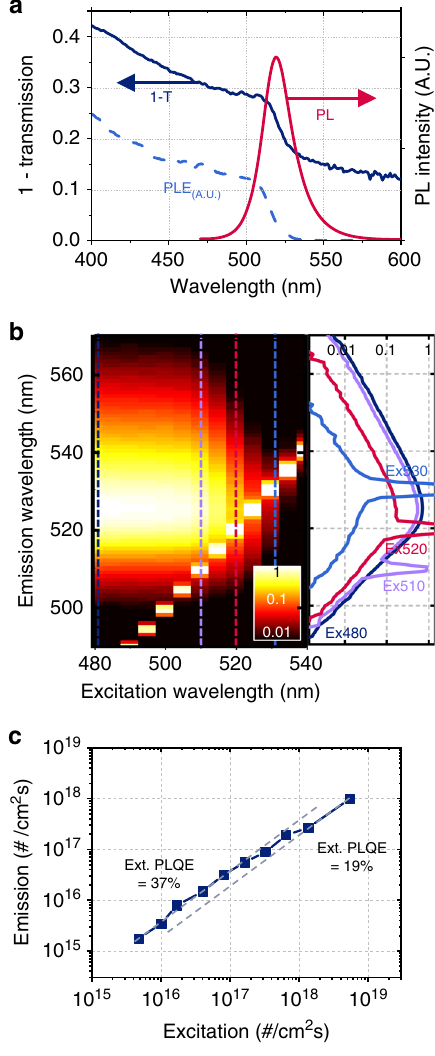
Fig. 1 Optical characterisation of perovskite fi lm. a Measured extinction ( = 1- transmission ), PL and PLE spectra of a 50 nm-thick perovskite fi lm. b Measured normalised PL spectra as a function of excitation wavelength. (left: excitation-scanned colour map. Right: spectra at excitation wavelengths of 480, 510, 520 and 530 nm.) The sharp peaks seen in the emission spectra are owing to detection of photons from the excitation source; for 530 nm excitation the spectral tail of the detected excitation causes some distortion of the overall spectrum. c Flux of emitted photons as a function of the fl ux of absorbed 405 nm photons, with lines indicating PLQEs of 37% and